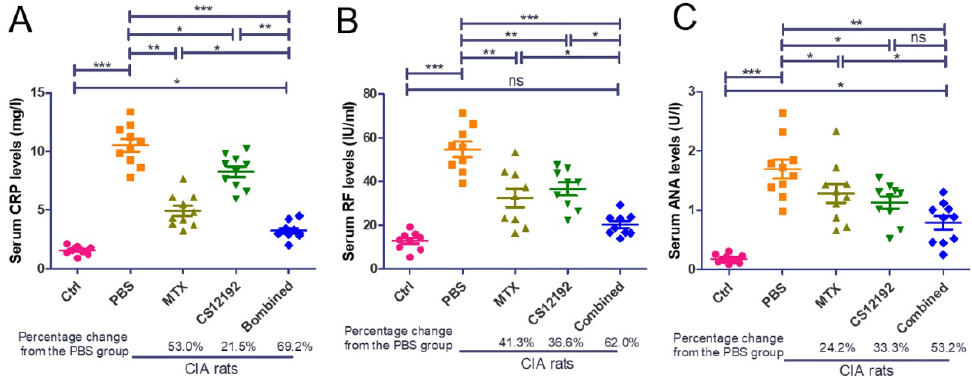
Figure 3. Therapeutic effects of MTX, CS12192 or the combination of CS12192 and MTX treatments on serum levels of CRP, RF, and ANA in CIA rats. Serum levels of CRP, RF, and ANA in CIA rats were measured by ELISA on day 28 after the first immunization. ( A ) Serum levels of CRP. ( B ) Serum levels of rheumatic factor (RF). ( C ) Serum levels of anti-nuclear antibody (ANA). Each dot represents one rat. * p < 0.05; ** p < 0.01; and *** p < 0.001 as indicated.